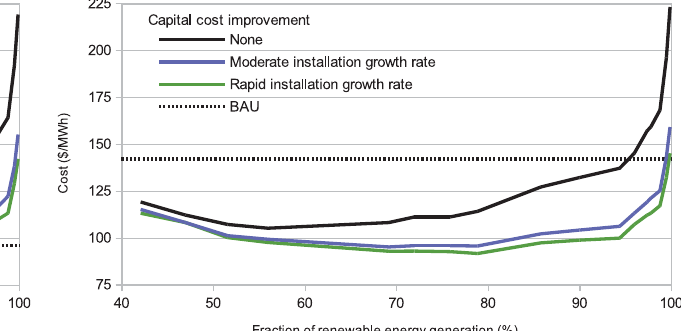
Fig. 3. Cost of partial renewable energy generation scenarios compared to business as usual (BAU) case (dashed line) with no carbon price. Renewable technologies used are wind, solar photovoltaic and distributed battery storage. Black line is no cost improvement over time, blue line is global cost improvement rates and moderate installation growth rates. Green line is global cost improvement rates and rapid installation growth rates. Cost is in Australian dollars.